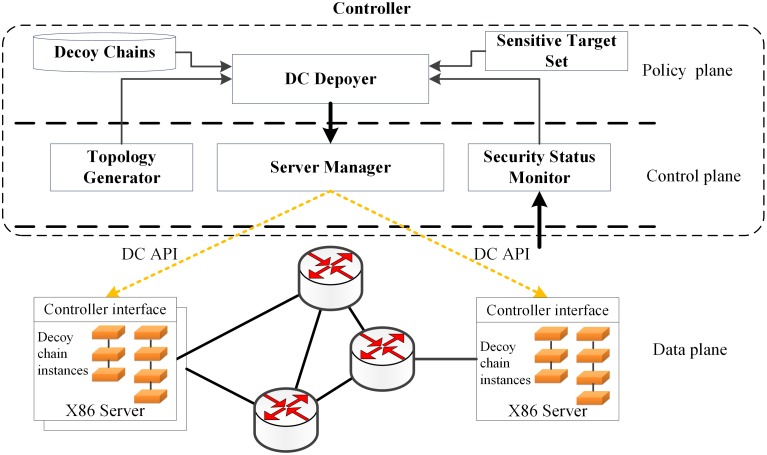
The schematic illustration of DCD system.